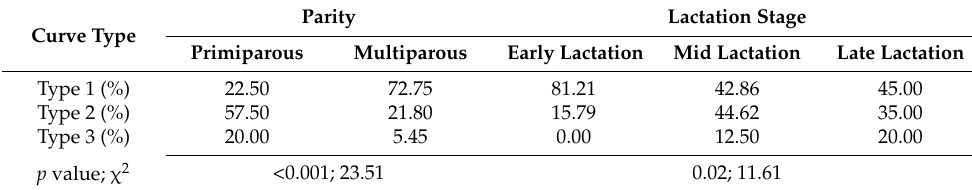
Table 3. Effect of parity and stage of lactation on patterns of milk flow kinetics.